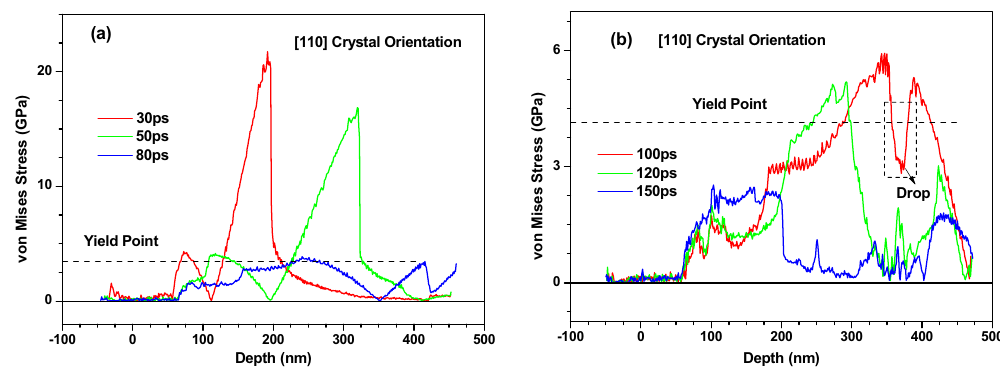
Figure 13. Equivalent stress (von Mises) distribution of 450 nm 〈 110 〉 copper films under an absorbed laser intensity of 0.065 J/cm 2 at 30–150 ps time